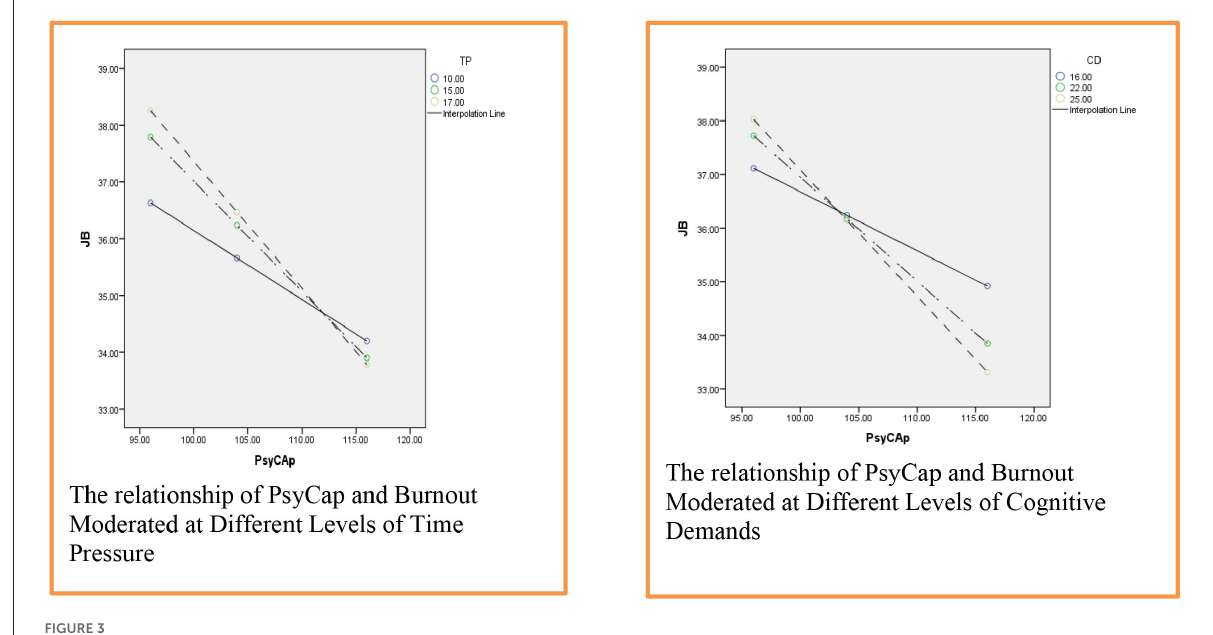
FIGURE3 The relationship of PsyCap and burnout moderated at different levels of time pressure, cognitive demands and social load (1,008).